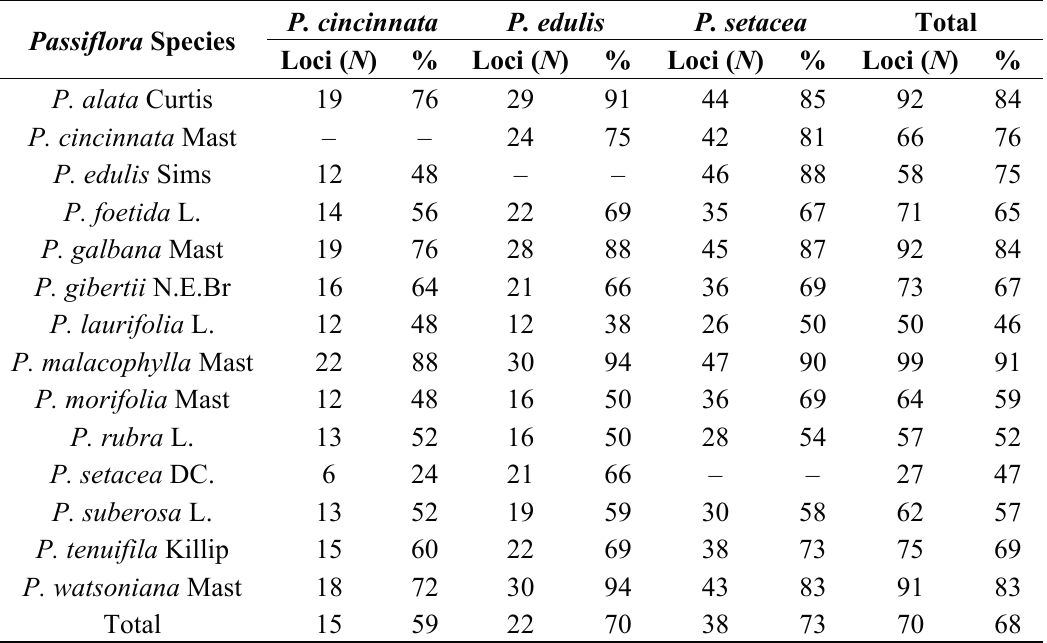
Table 1. Cross-species amplification observed using a set of 109 primer pairs a developed for Passiflora cincinnata (25 loci), Passiflora edulis (32) and Passiflora setacea (52) in 14 passion fruit species from the germplasm bank of Embrapa Cassava & Fruits. Passiflora Species